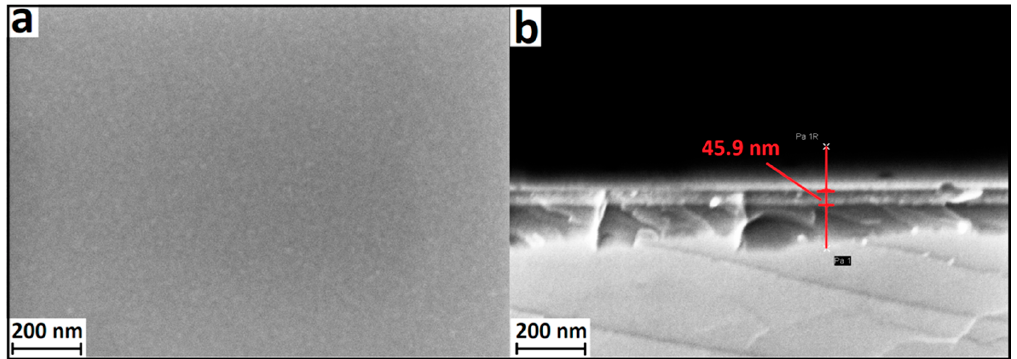
Figure 2. SEM of the surface ( a ) and cleavage ( b ) of the Ta-O_6 sample on a Si